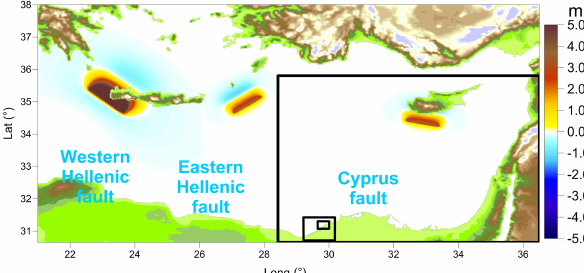
Figure 2. Initial sea surface elevation for the three tsunami scenar- ios treated in the paper. Tsunami simulations are carried out in four grids: the outer grid (grid 1) coincides with the map shown here, while the three black boxes show the boundaries of the three nested grids (grid 2 to 4). Grid 4, centred on Alexandria, has two differ- ent topo-bathymetric data: one for the mean-sea-level tsunami sim- ulations and one for the maximum high-tide tsunami simulations, which differ by the uniform static value of